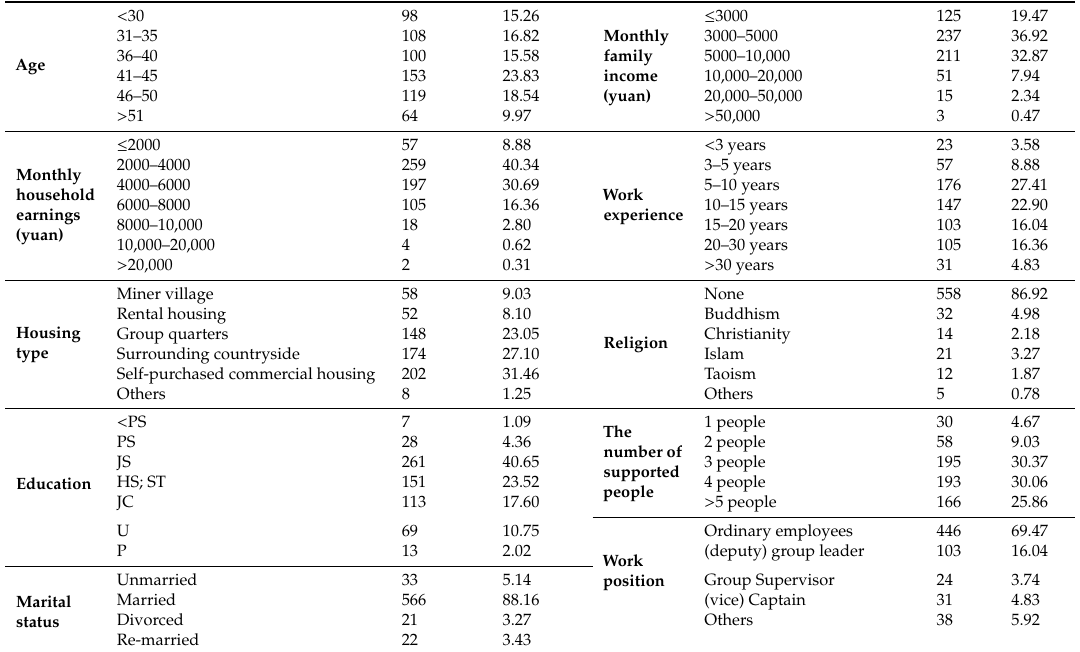
Table A1. The frequency and percentage of social demographic variables of all participants.